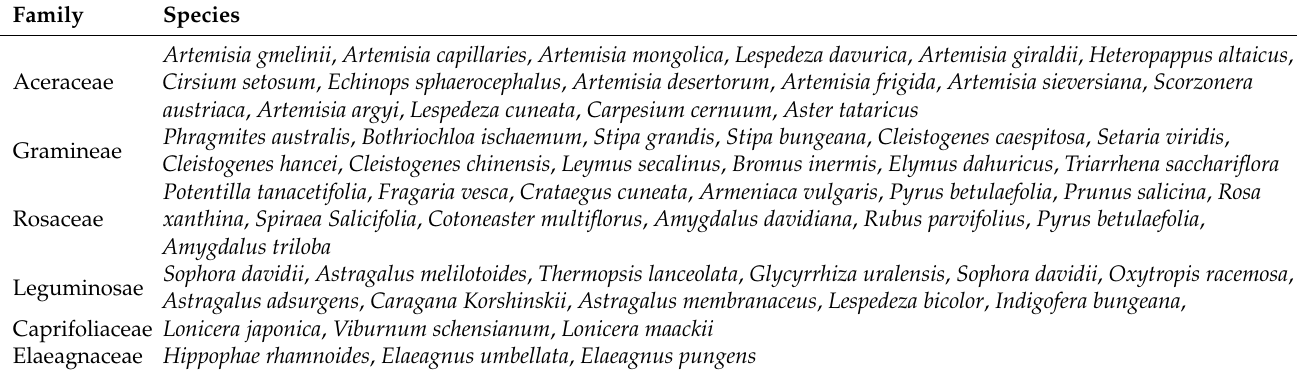
Table A2. Description of families with a record number greater than